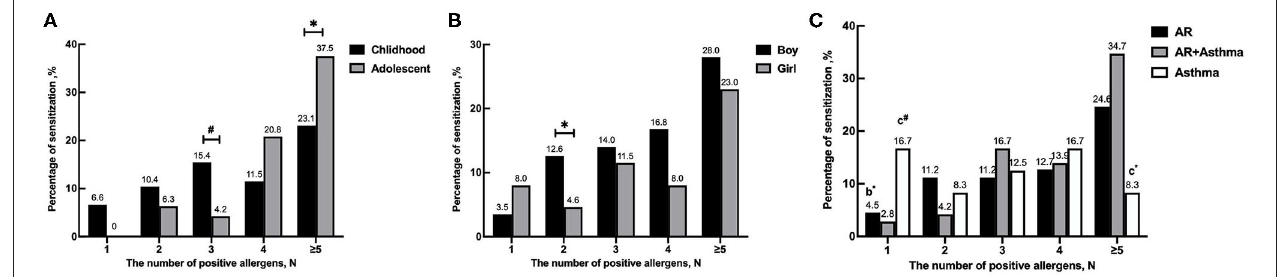
FIGURE 2 | Sensitization to different number of positive allergens in different ages, genders and disease groups. (A) The number of positive allergens in different ages. (B) The number of positive allergens in different genders. (C) The number of positive allergens in different diseases. * P < 0.05, # P < 0.01. b Compared between AR group and asthma group. c Compared between AR combined with asthma group and asthma group.